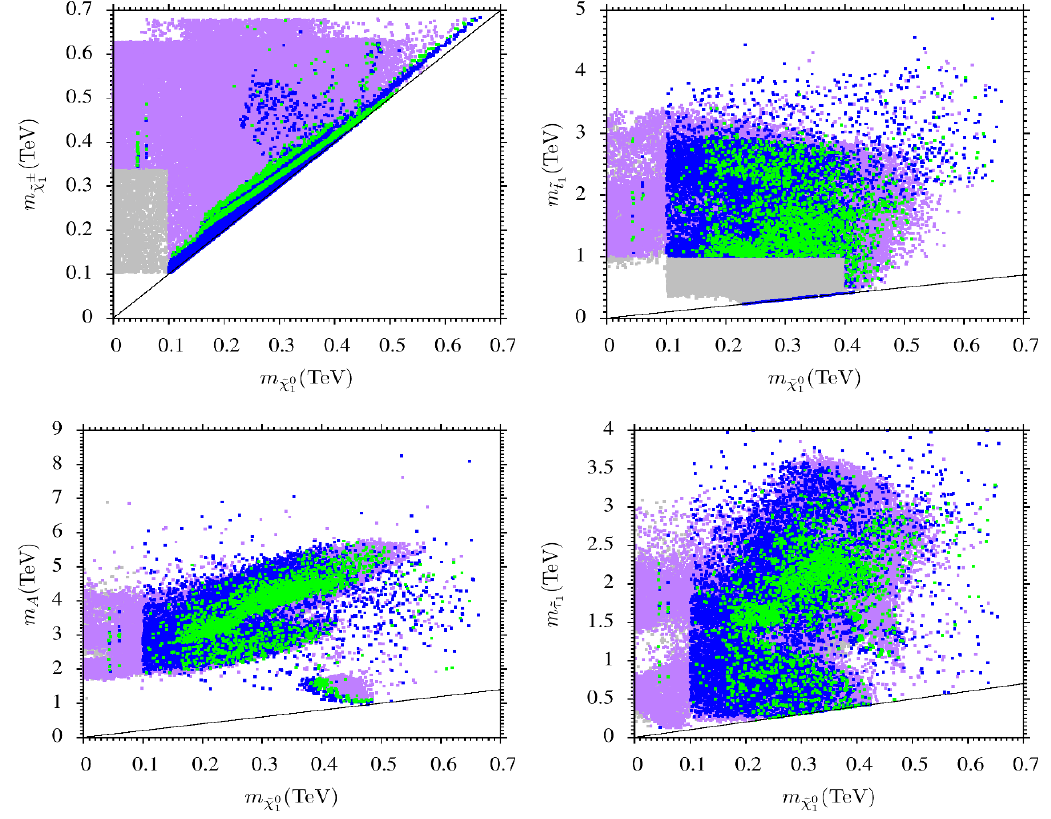
Figure 3 . Points of the scan with (cid:1) EW (cid:20) 100 shown on the plane of the LSP mass m lightest chargino mass m left), lightest stau mass m